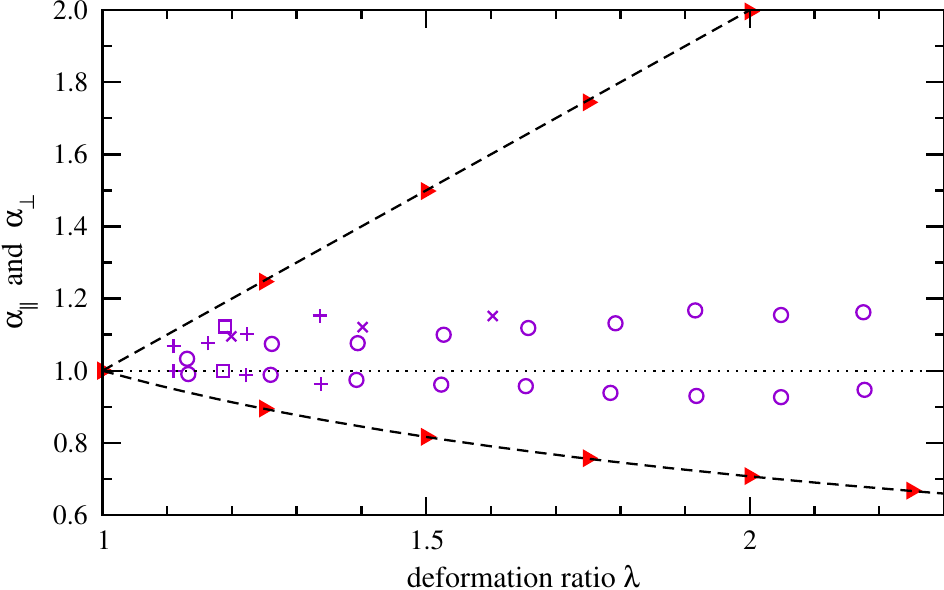
Figure 10. Ratios of root-mean-squared contributions to end-to-end distance in directions parallel and perpendicular to the deformation direction, normalized by contributions in the absence of deformation. Simulation results depict cis-1,4-polybutadiene of 50 repeat units at 300 K ( (cid:73) red). Equivalent radius of gyration data measured by neutron scattering [34] are shown for PDMS of increasing molecular weight ( (cid:3) ; + ; × ; ◦ violet). Dashed lines indicate changes expected for locally affine deformation. Parallel and perpendicular ratios are above and below the dotted